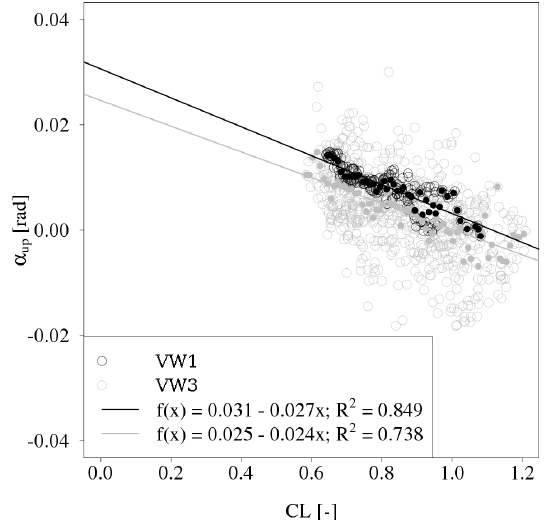
Fig. 9. Upwash attack angle ( α up ) as function of the lift coefficient ( CL ) for two vertical wind specific flight patterns on 25 June 2008 (VW1, VW3). α up is the difference of attack angle as measured by the five hole probe and the inverse reference of the free airstream attack angle (Sect. 4.1 Step G3). Open circles depict the entire 1Hz dataset. Full circles are averages after binning over increments of 0.01 CL .